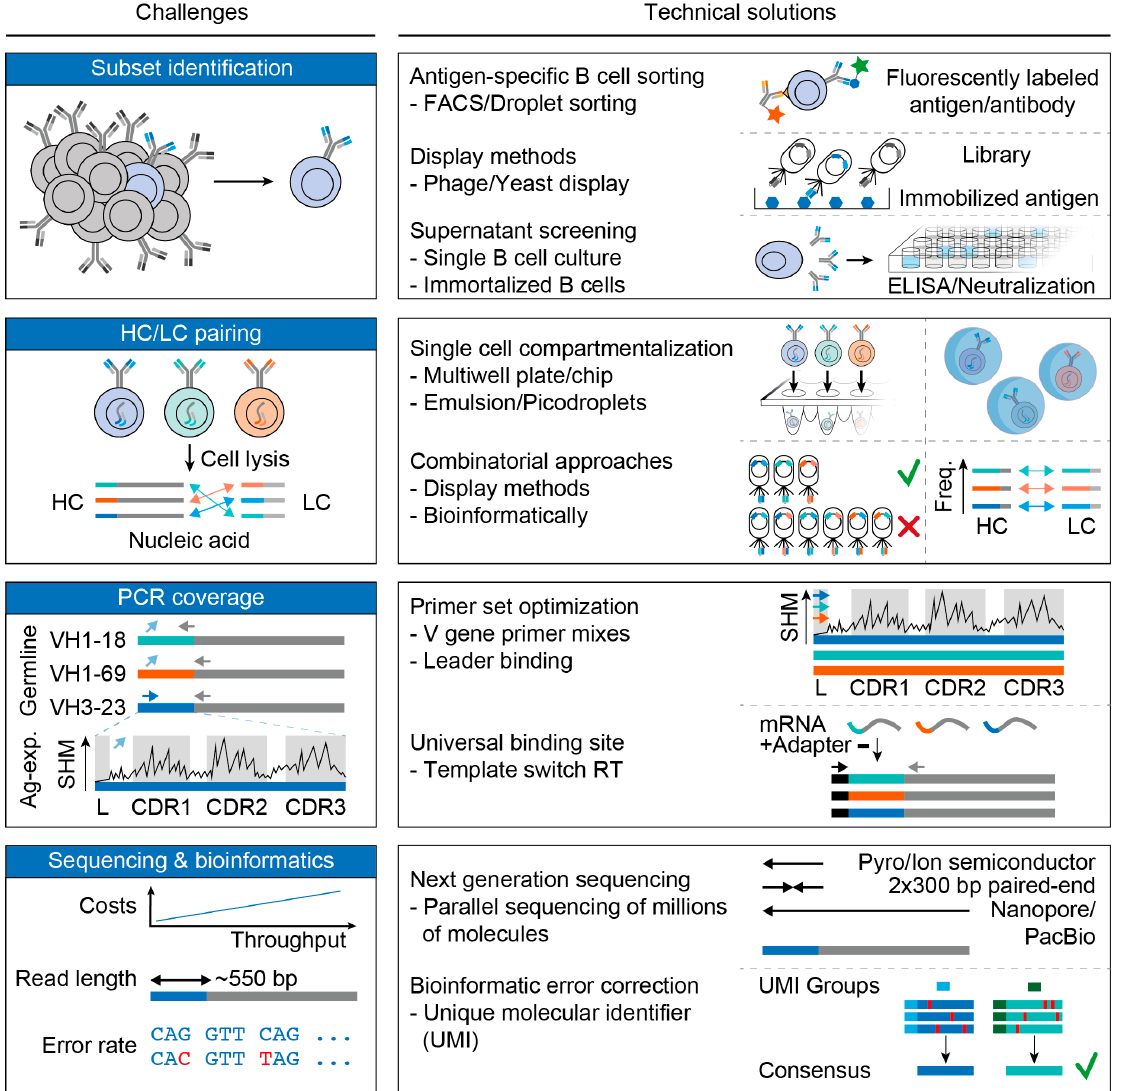
Figure 3. Technical solutions to challenges for B cell receptor analyses. HC: heavy chain, LC: light chain, Freq: frequency, Ag-exp: antigen-experienced, SHM: somatic hypermutation, VH: V gene segment of the heavy chain, L: leader region, CDR1/2/3: complementarity determining region 1/2/3, mRNA: messenger RNA.